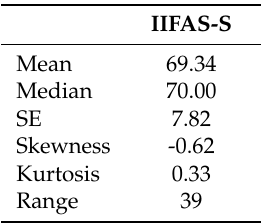
Table A2. Score distribution of the Spanish (IIFAS-S) version of the Iowa Infant Feeding Attitude Scale